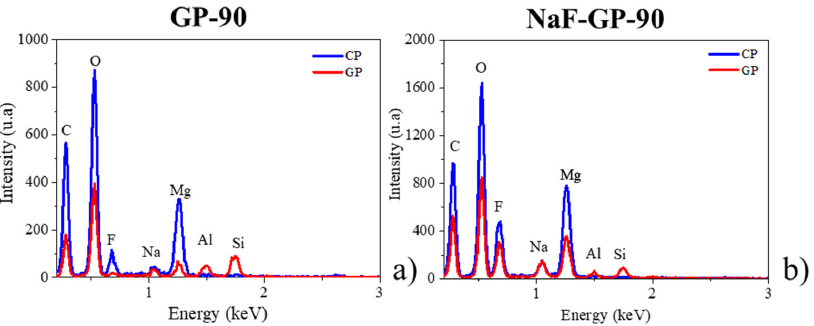
Figure 5. EDX spectra measured in CP at a distance of 5 μ m from the CP layer for ( a ) GP and ( b ) GP ‐ NaF samples. ( b ) GP-NaF samples.